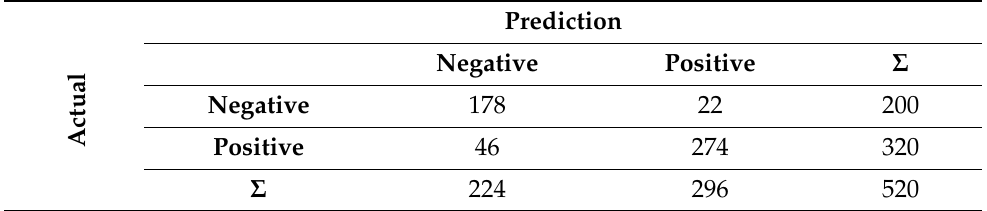
Table 3. Confusion Matrix of Naive Bayes Classification.